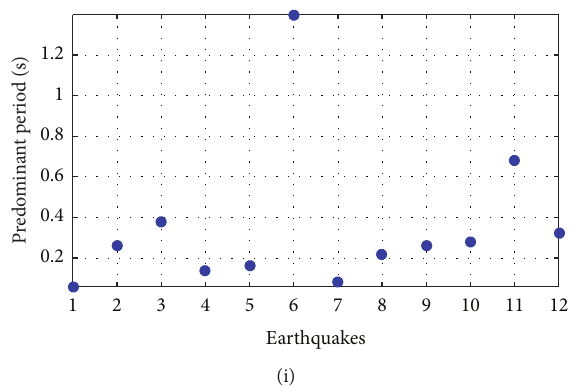
Figure 4: Additional characteristics of the utilized ground motions.